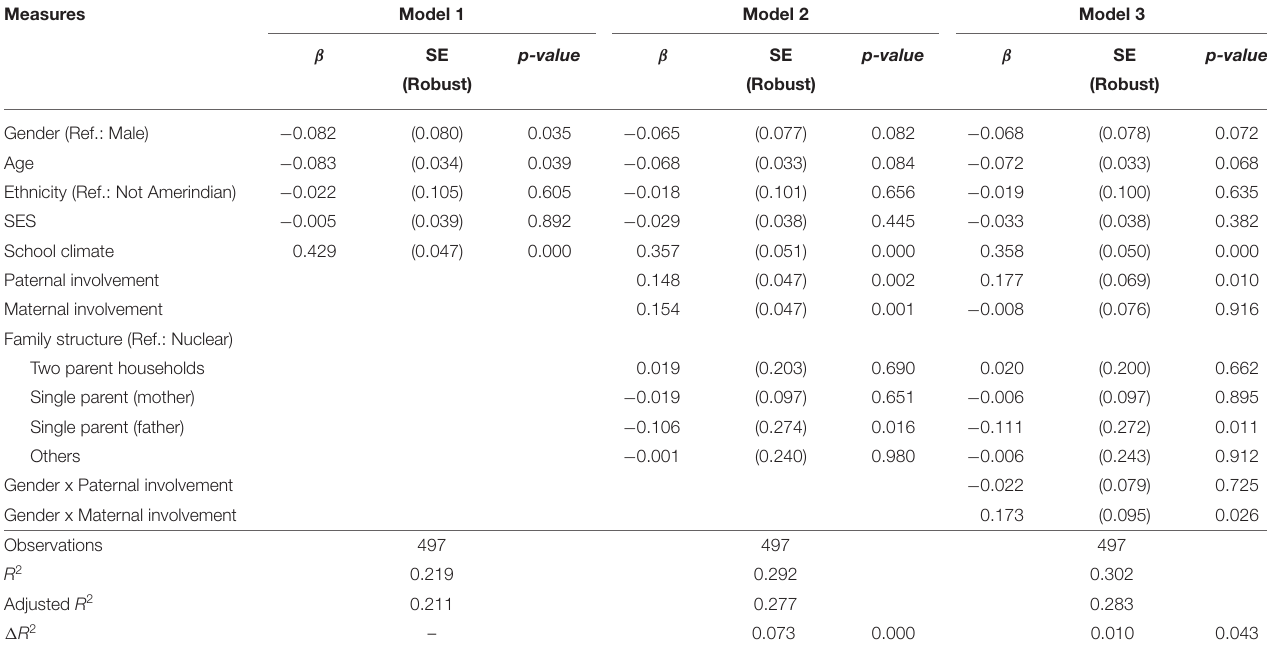
TABLE 3 | Hierarchical regression models predicting adolescents’ life satisfaction